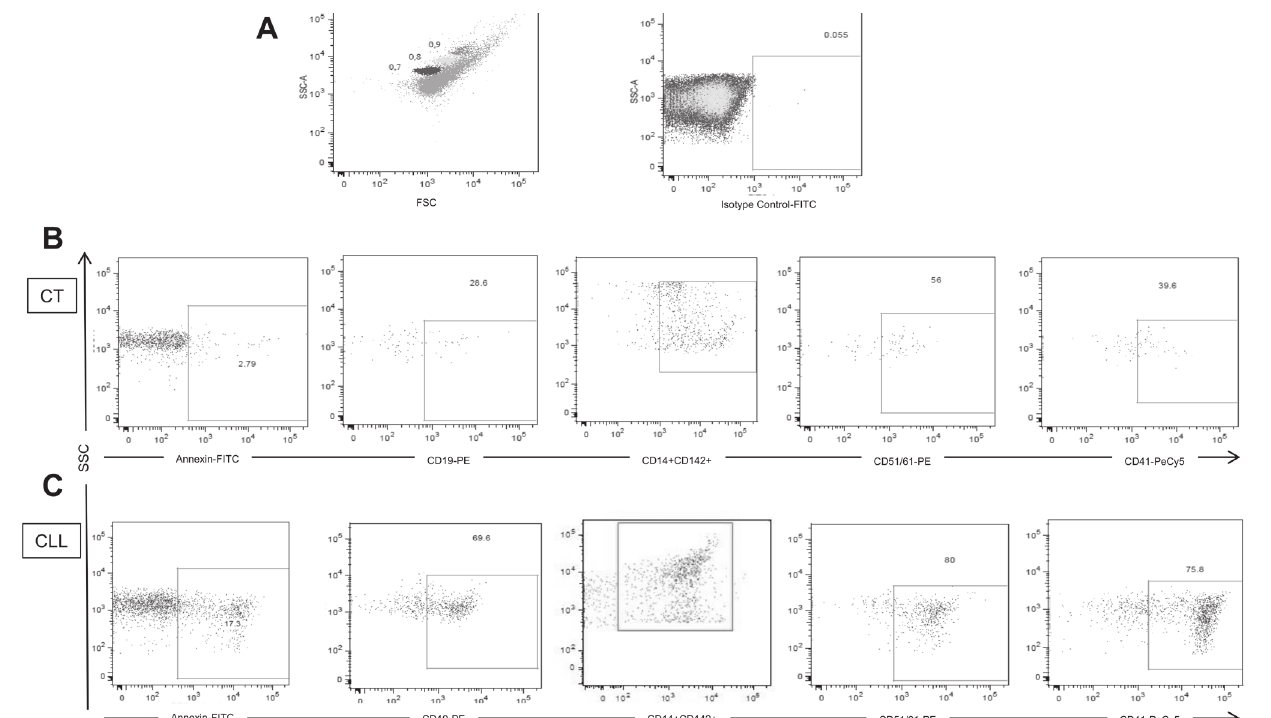
FIGURE 1 - Isolated MPs were gated based on their forward (FSC) and side (SSC) scatter distribution as compared to 0.7-0.9 μm synthetic MPs and Mouse IgG FITC-conjugated isotype control (A). Events present on the gate were assessed for their annexin V positive staining, using FITC-conjugated monoclonal antibodies and subsequent identification of the source of MPs, using cell-specific monoclonal antibodies (CD19-PE for lymphocyte, CD41-PeCy5.5 for platelets, CD51/61-PE for endhotelial cells) in control groups (B) and CLL patients